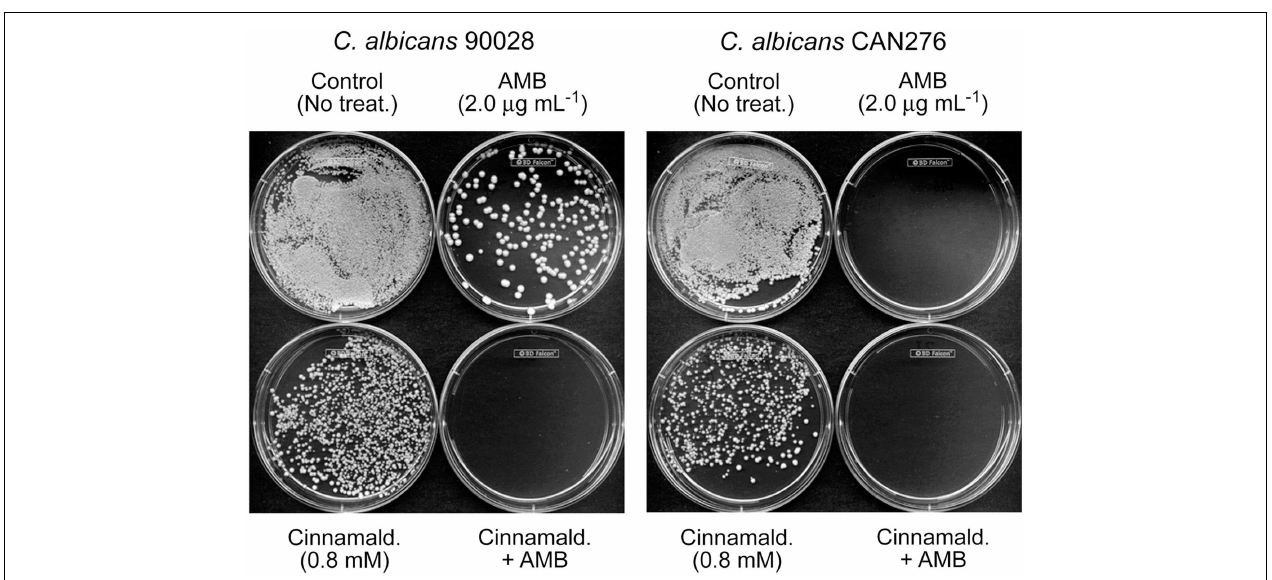
survival, while survived colonies appeared under the independent treatment of AMB or cinnamaldehyde. Similar assay was performed on C. albicans